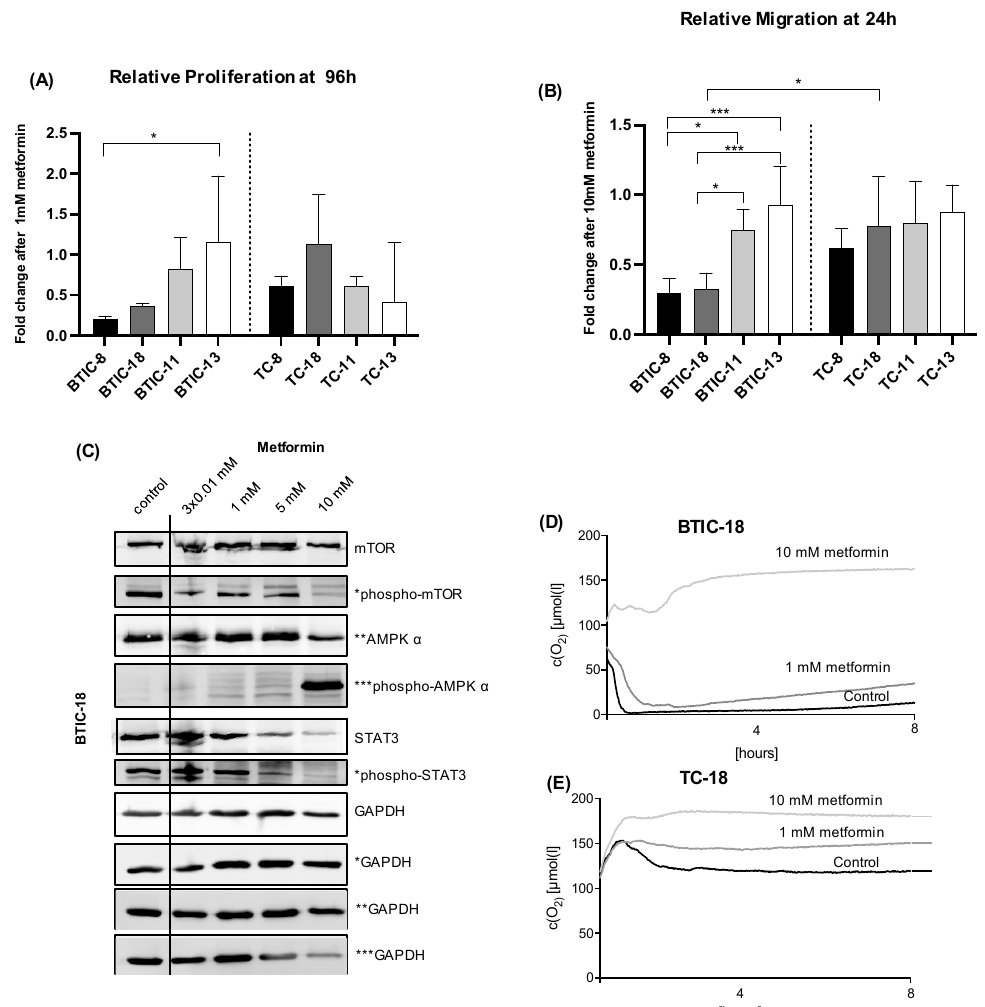
Figure 2. Effects of metformin on BTICs and TCs. ( A ) We compared proliferation of proneural (-8, -18) and mesenchymal BTICs (-11, -13) and TCs with or without 1 mM metformin after 96 h of treatment (fold change metformin/control). Proliferation was normalized to the 0 h value. Proneural BTIC-8 and -18 showed lower proliferation rates after metformin treatment than mesenchymal BTIC-11 and -13. ( B ) Migration of proneural (-8, -18) and mesenchymal (-11, -13) BTICs and TCs with or without 10 mM metformin was measured after 24 h of treatment. Migration was normalized to the 0 h value and results are presented as fold change metformin/control. Proneural BTIC-8 and -18 showed lower migration rates than mesenchymal BTIC-11 and 13, and also compared to proneural and mesenchymal TCs. ( C ) Increasing doses of metformin led to inhibition of mTOR and activation of AMPK in Western blot analyses after 48 h of treatment in BTIC-18. Asterisks next to the blots are indicative of the corresponding GAPDH control. Oxygen consumption over 8 h (PreSens Assay) decreased under treatment with metformin in both ( D ) BTIC-18 and ( E ) TC-18, but levels of endogenous oxygen consumption varied markedly. All assays were performed in triplicate. Significant results are only depicted for valid comparisons, i.e., comparing proneural and mesenchymal BTICs or proneural and mesenchymal TCs, or the corresponding BTIC and TC pair. Asterisks indicate * p < 0.05, ** p < 0.01, *** p <